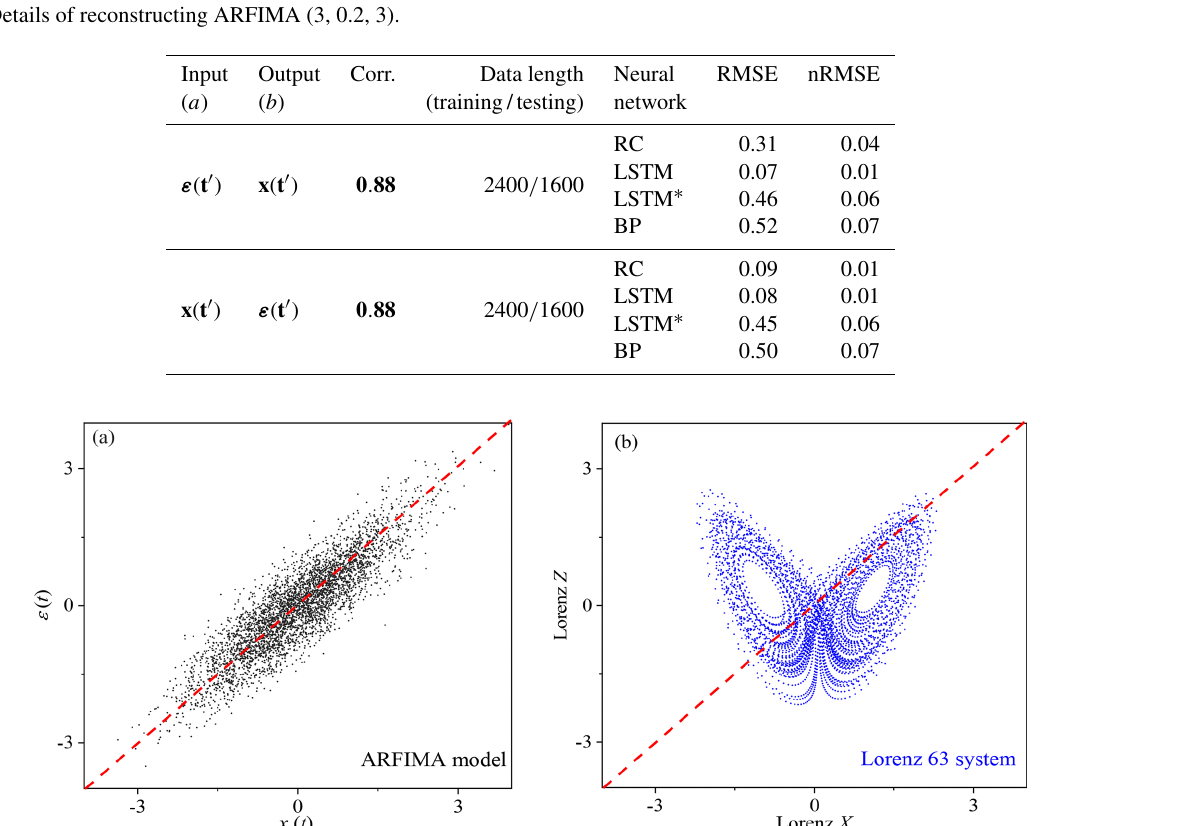
Table 1. Details of reconstructing ARFIMA (3, 0.2, 3).